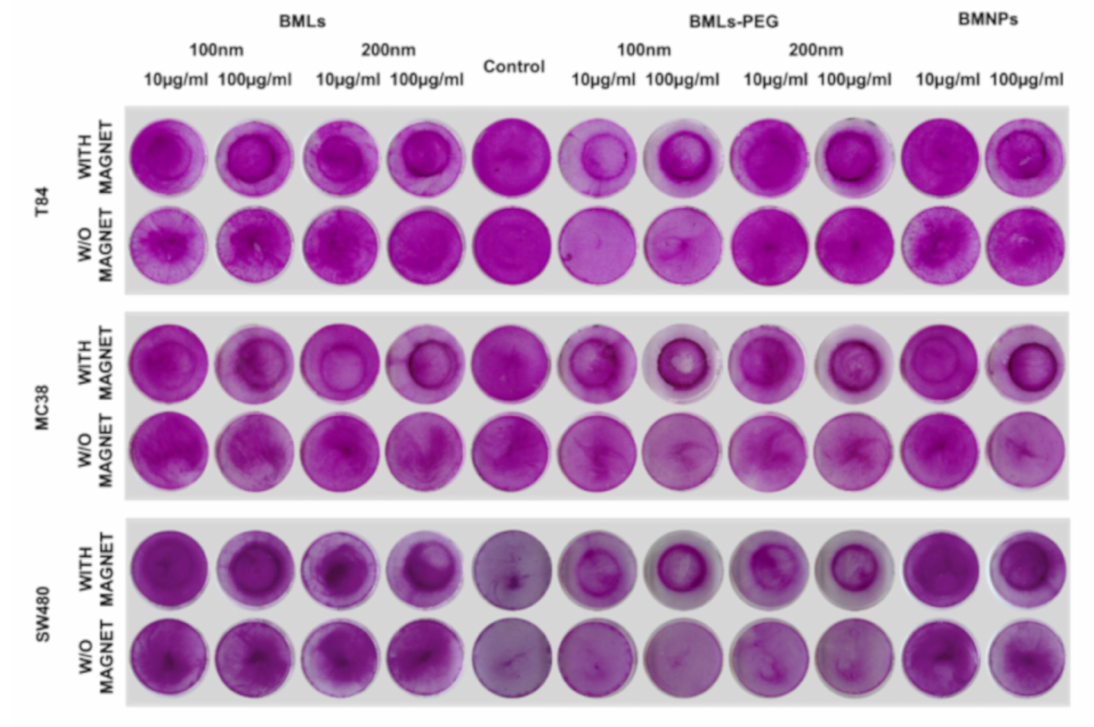
Figure 7. Cell migration assay. Representative image of colon cancer cells (T84, MC38 and SW480) exposed to di ff erent concentrations of BMLs, BMNPs and FeCl 3 and stained with SRB. Migration of the cells after treatments was evaluated in the presence or absence of a